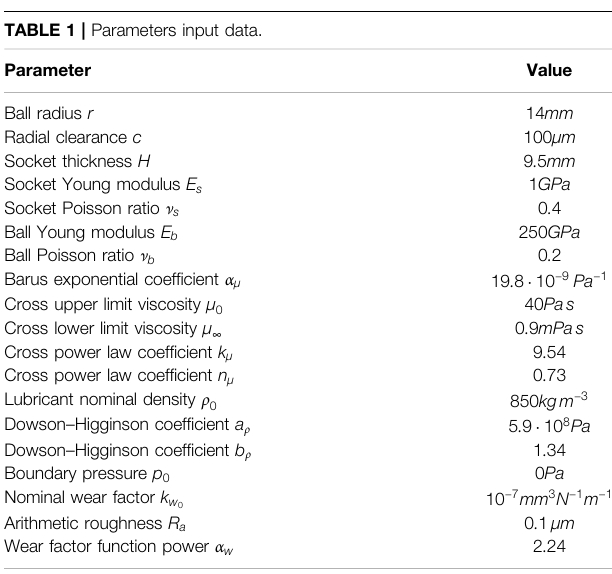
TABLE 1 | Parameters input